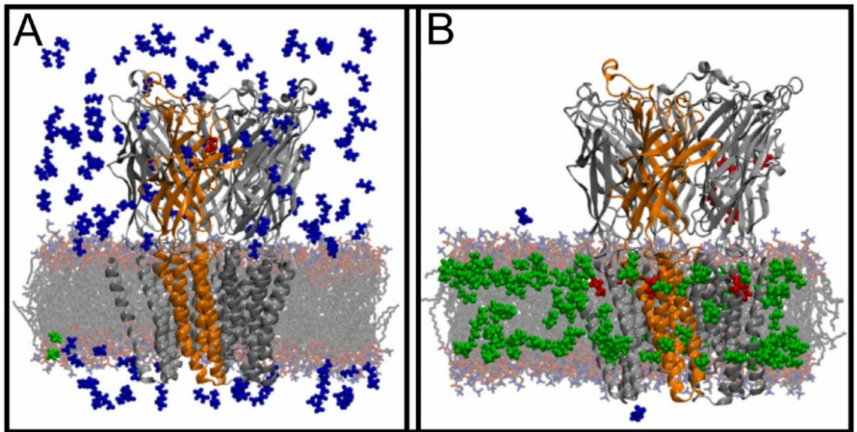
Figure 19. Partitioning of desflurane into the membrane and Gloeobacter violaceus ligand-gated ion channel studied using a flooding simulation. Snapshots of the simulated model at the ( A ) beginning and ( B ) end of the simulation. Desflurane molecules were colored according to their location: blue—water phase, green—lipid bilayer, red—ion channel. Reproduced with permission from ref.